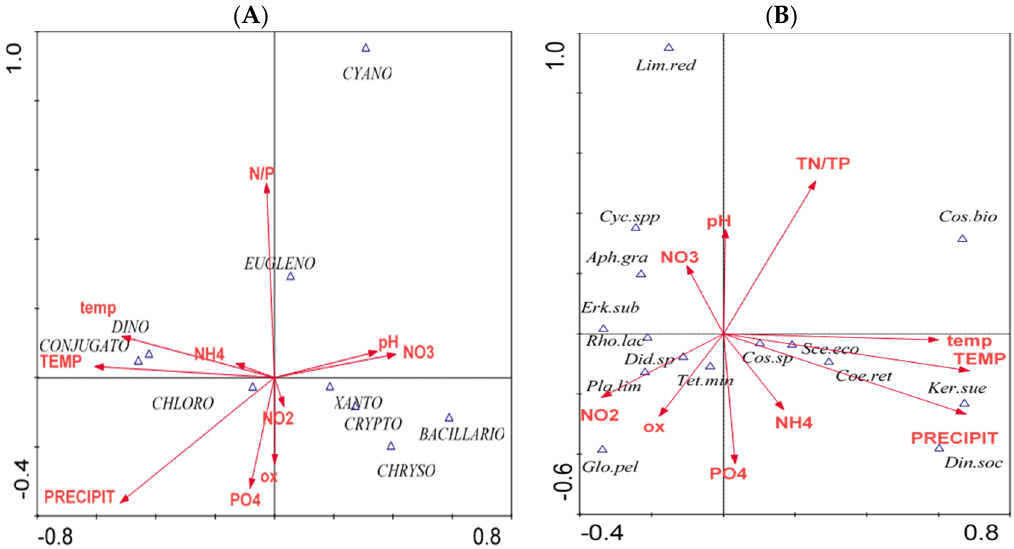
Figure 10. Canonical Correspondence Analysis (CCA) diagrams showing the relationships between: ( A ) environmental variables and abundance of phytoplankton groups; ( B ) environmental variables and phytoplankton dominating taxa. Abbreviations: Aph . gra — Aphanizomenon gracile ; Coel . ret — Coelastrum reticulatum ; Cos . bio — Cosmarium bioculatum ; Cos .sp— Cosmarium sp.; Cyc .spp— Cyclotella sp.; Did .sp.— Didymocystis sp.; Din . soc — Dinobryon sociale ; Erk . sub — Erkenia subaequiciliata ; Glo . pel — Gloeotila pelagica ; Ker . sue — Keratococcus suecicus ; Lim . red — Limnothrix redekei ; Plb . lim — Planktolyngbya limnetica ; Rho . lac — Rhodomonas lacustris ; Sce . eco — Scenedesmus ecornis ; Tet . min — Tetraëdron minimum . Table 1. Results of the Monte Carlo permutation test.